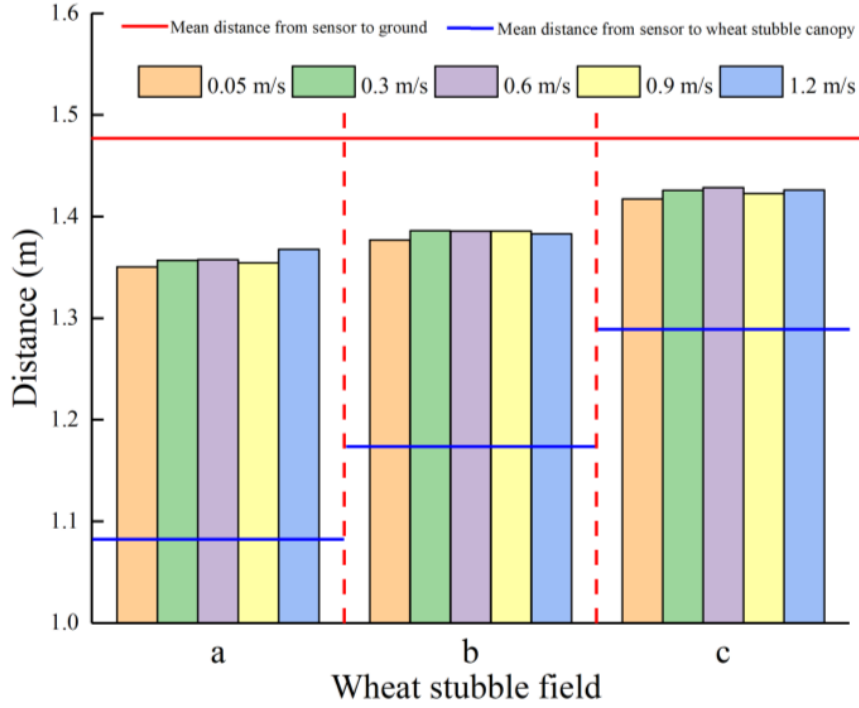
Figure 10. Distances detected by the LiDAR sensor at different H WS and V LiDAR.